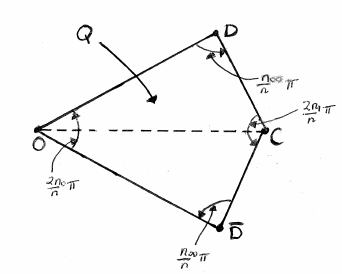
Figure 2. The rational quadrilateral Q